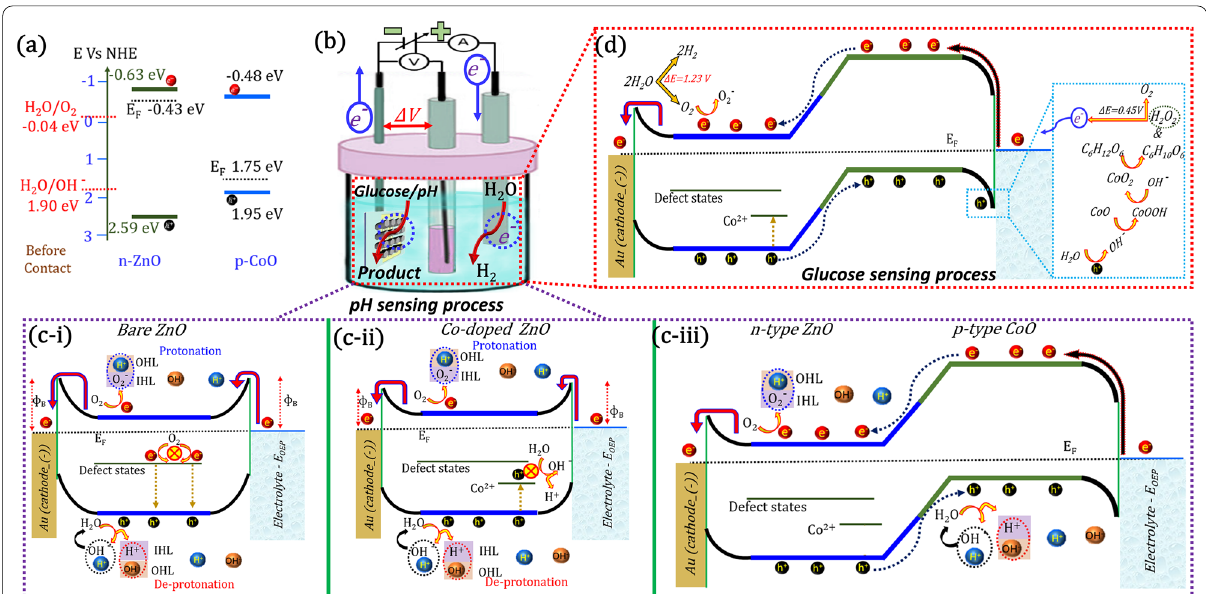
Fig. 7 Schematic illustration of energy bands of ZnO and CoO a before contact, b setup used for glucose/pH sensing, illustration of the process involved in c (i–iii) pH and d glucose